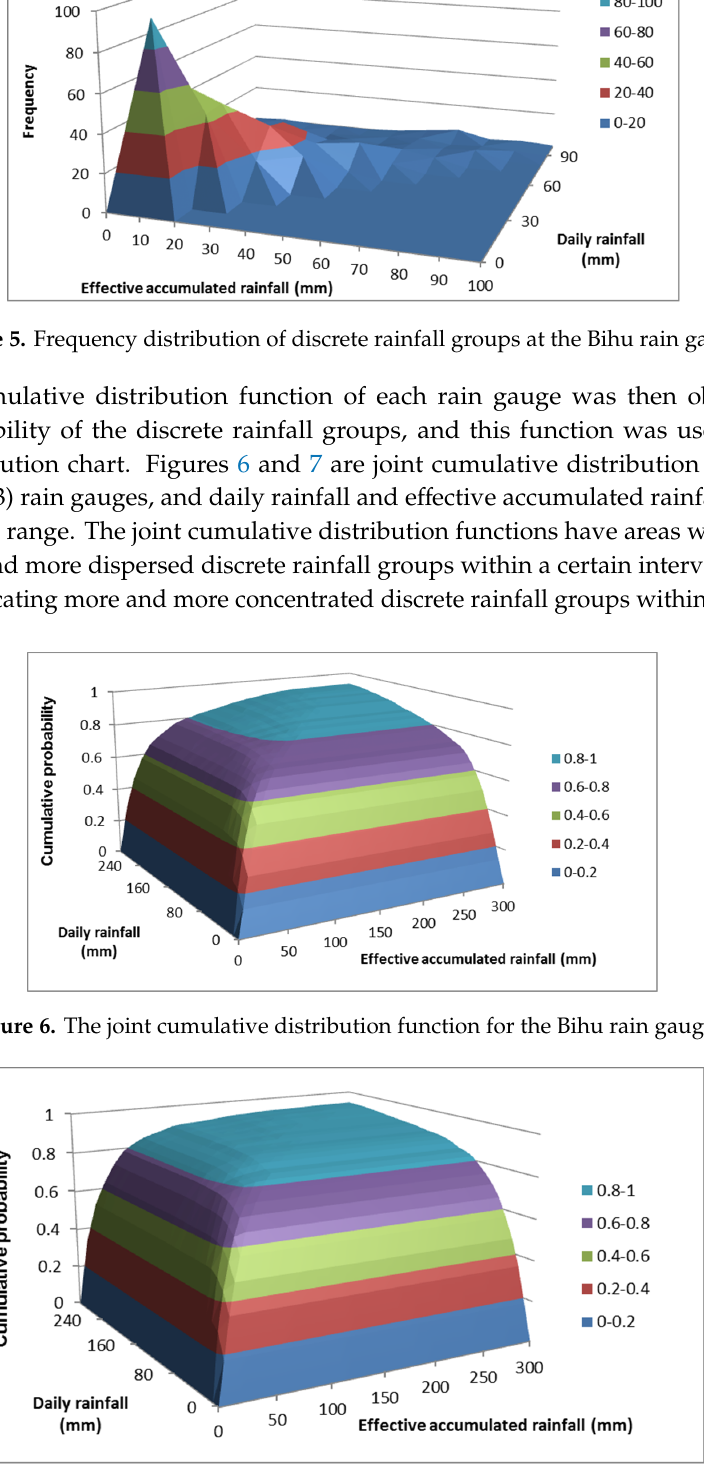
Figure 7. The joint cumulative distribution function for the Fushan (3) rain gauge.